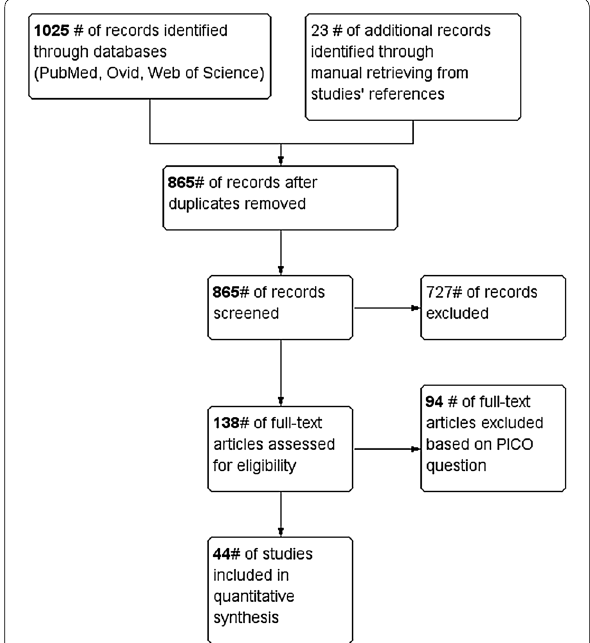
Fig. 1 Flow chart showing study identification, inclusion, and exclu-